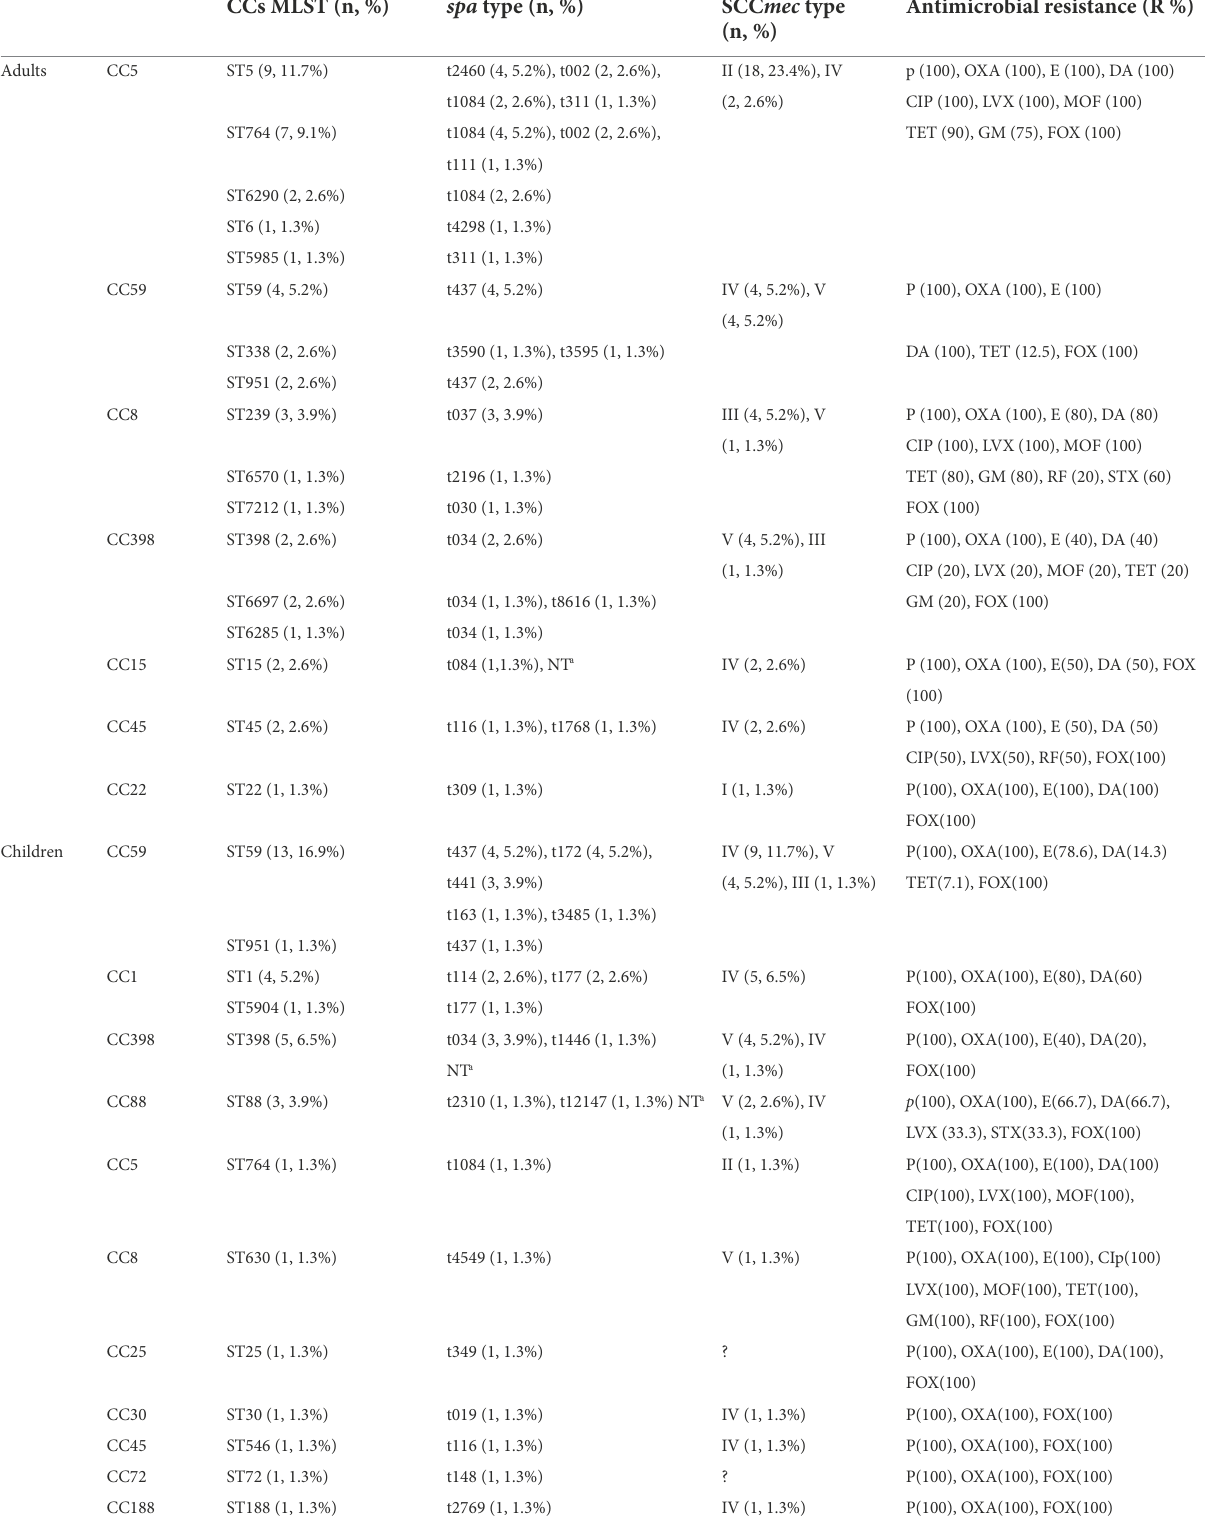
TABLE 1 Molecular characteristics and antibiotic resistance profiles of 77 bloodstream infection methicillin-resistant S. aureus (MRSA) obtained from inpatients. CCs MLST (n, %) spa type (n, %) SCC mec type